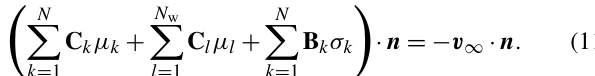
Figure 6. Pressure distribution over a NACA0012 wing section, α = 6 ◦